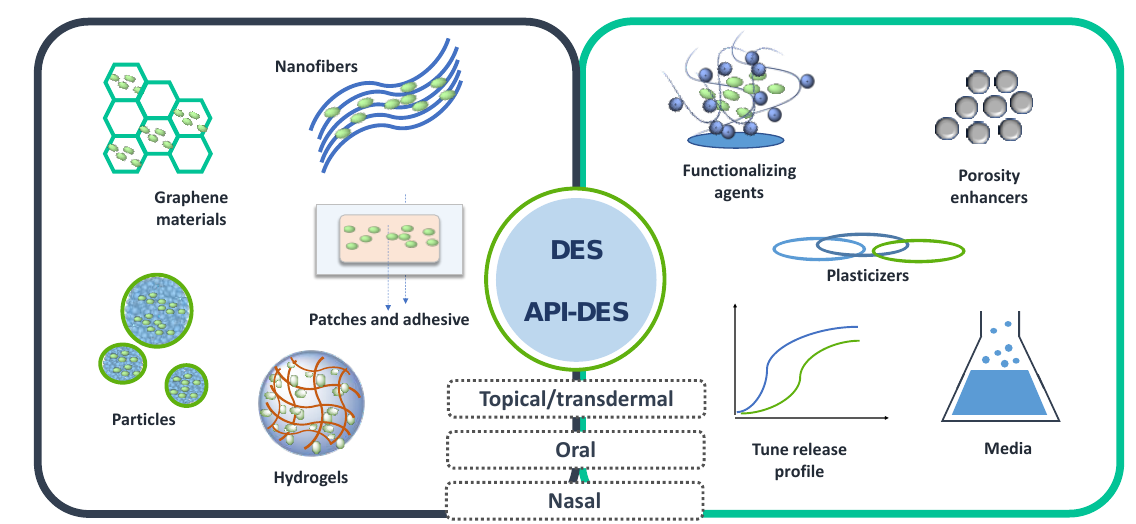
Figure 5. Schematic representation of the type of DES-based drug delivery systems developed ( left ) and the DES function in the design and efficacy of these systems ( right ).